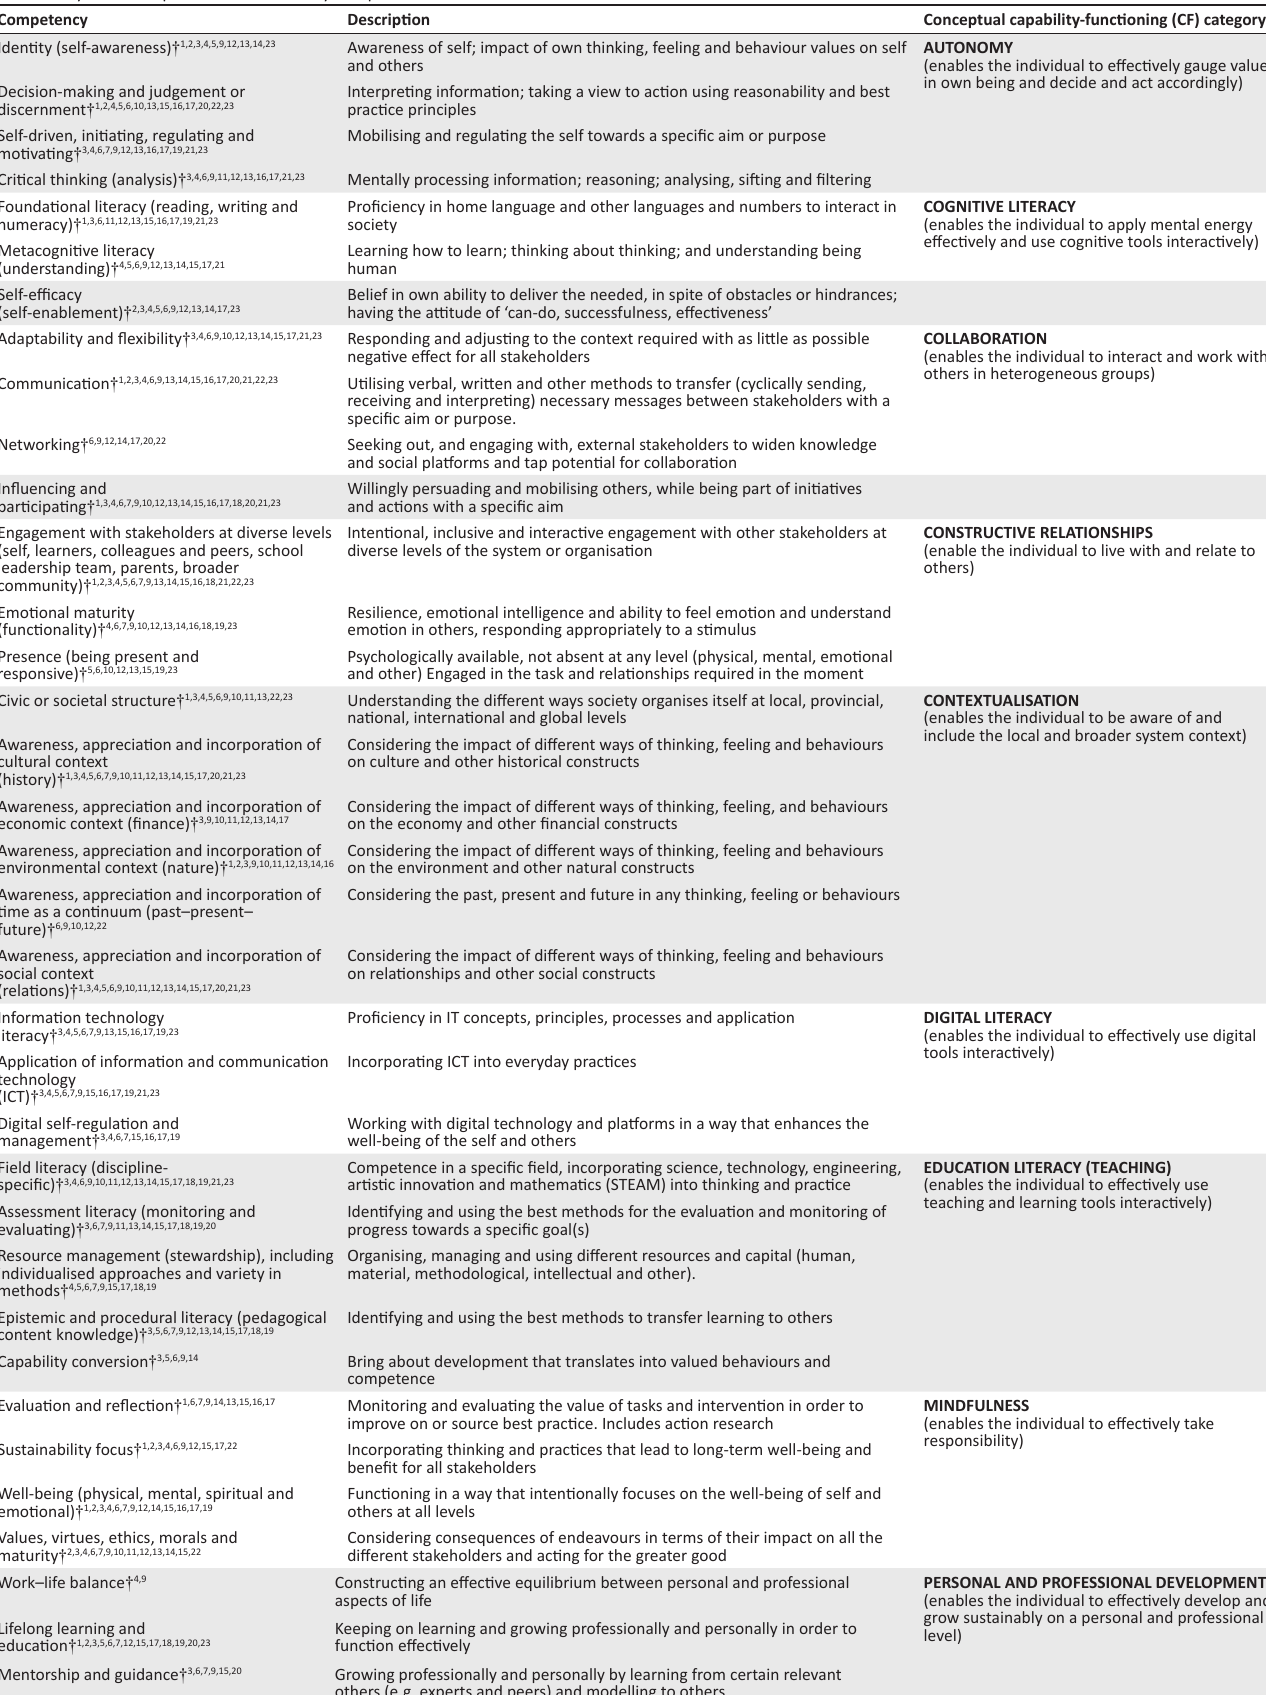
TABLE 1: Synthesis of potential 21st-century competencies. Competency Description Conceptual capability-functioning (CF)